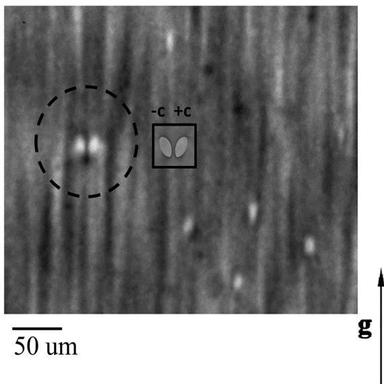
High magnification image of an area with a pair of opposite sign TSDs. The contrast matches the simulated image in the inset picture.